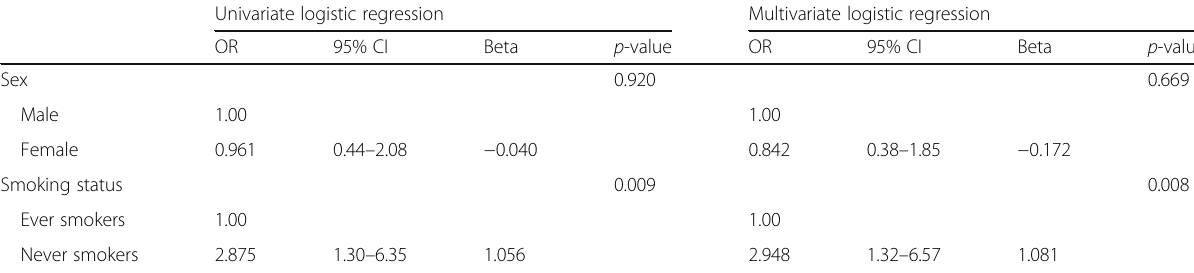
Table 9 Logistic regression analysis of ALK rearrangement Univariate logistic regression